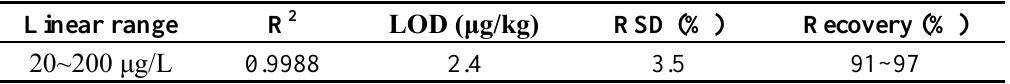
Table 1. The linear range, limit of detection, recovery and precision of the